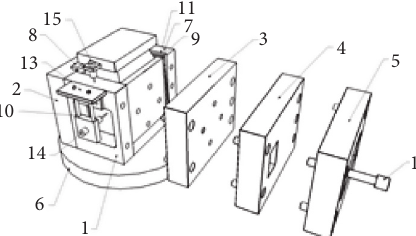
Figure 1: Apparatus for simulation of surface instability.1: front wall; 2: left wall; 3: perforated wall; 4: half window wall; 5: full-window wall; 6: base; 7: back wall; 8: wedge plate; 9: FRP backing plate; 10: square specimen; 11: ordinary steel base plate; 12: high strength bolt; 13: LVDT